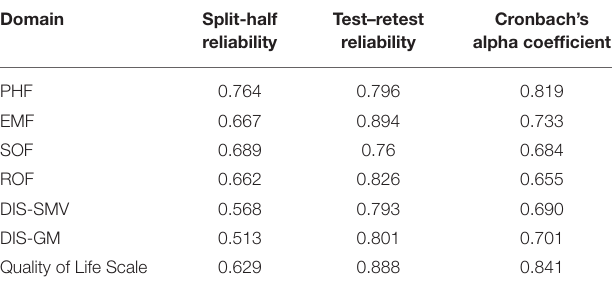
TABLE 4 | Scale structure of the final